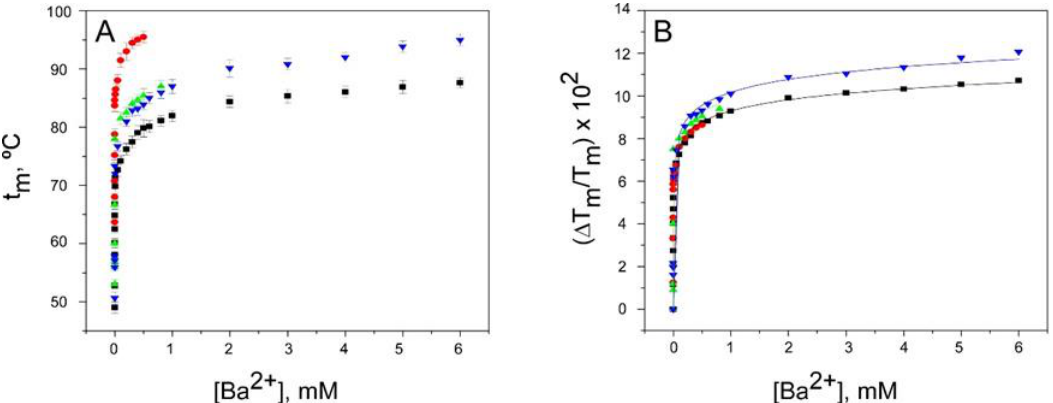
Figure 4. Binding of Ba 2+ to KcsA. Panel A illustrates Ba 2+ binding to KcsA channels, monitored through the Ba 2+ concentration dependence of the t m of thermal denaturation. The results are the average ( n = 3) t m (in Celsius) ± SD. The symbols and colors are the same as in Figure 2 . Panel B shows the fitting of the experimental data from Panel A to Equation 1 (see Methods). The apparent K D values for the above binding events are given in Table 1.